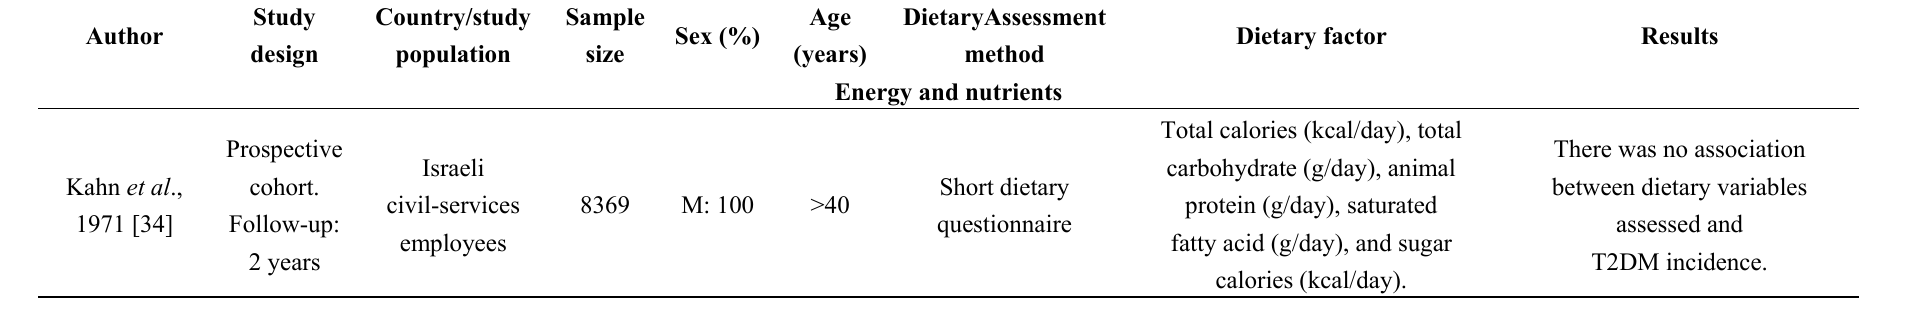
Table 1. Association of energy, nutrients, foods, and beverages with